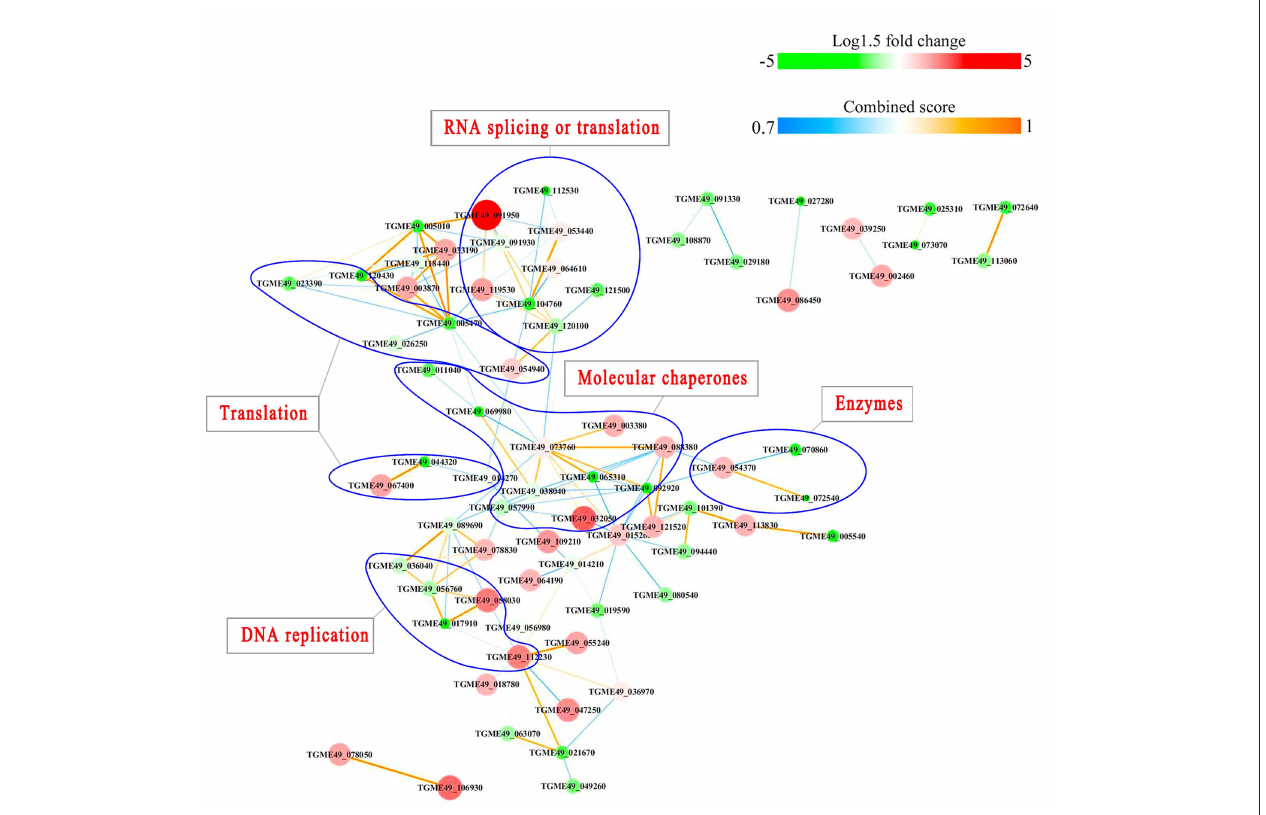
FIGURE 12 | Interactions network of the phosphoproteinsup/down-regulated in PYS strain when comparing PYS/RH strains. Nodes represent phosphoproteins and edges denote interactors between phosphoproteins. The upregulation and downregulation of phosphoproteins were characterized by the color and size of nodes. Red and large size nodes represent up-regulated phosphoproteins in PYS, whereas green and small size node denote down-regulated phosphoproteins in PYS. The color of edge represents the combined score of